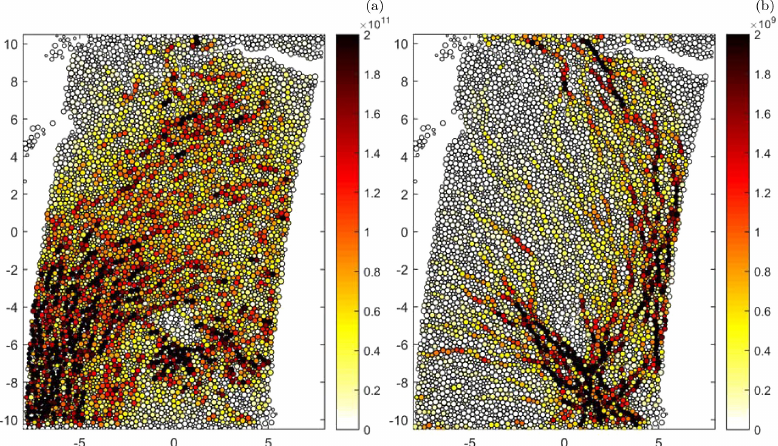
Figure 11. Instantaneous shear stress (color scale; in Pa) acting on individual grains due to bond interactions (a) and pairwise interactions (b) in simulation under shear strain at t = 2000s (see Figs. 7 and 9). Reference model settings. Note different color scales in (a) and (b)